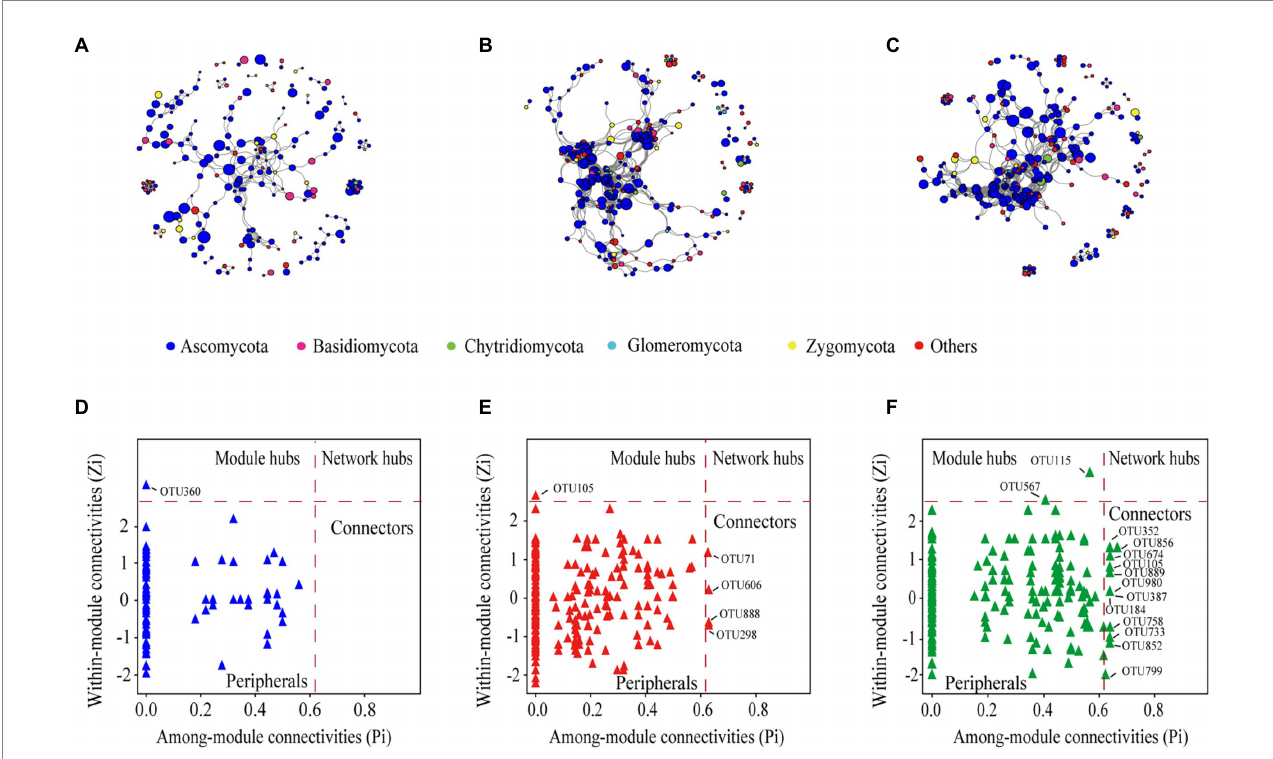
FIGURE 5 The co-occurrence network of soil fungal community in monoculture (A) , rotation (B) , and mixture (C) , the size of each node is proportional to its relative abundance. Zi-Pi plots showing the distribution of OTUs based on their topological roles in monoculture (D) , rotation (E) , and mixture (F)